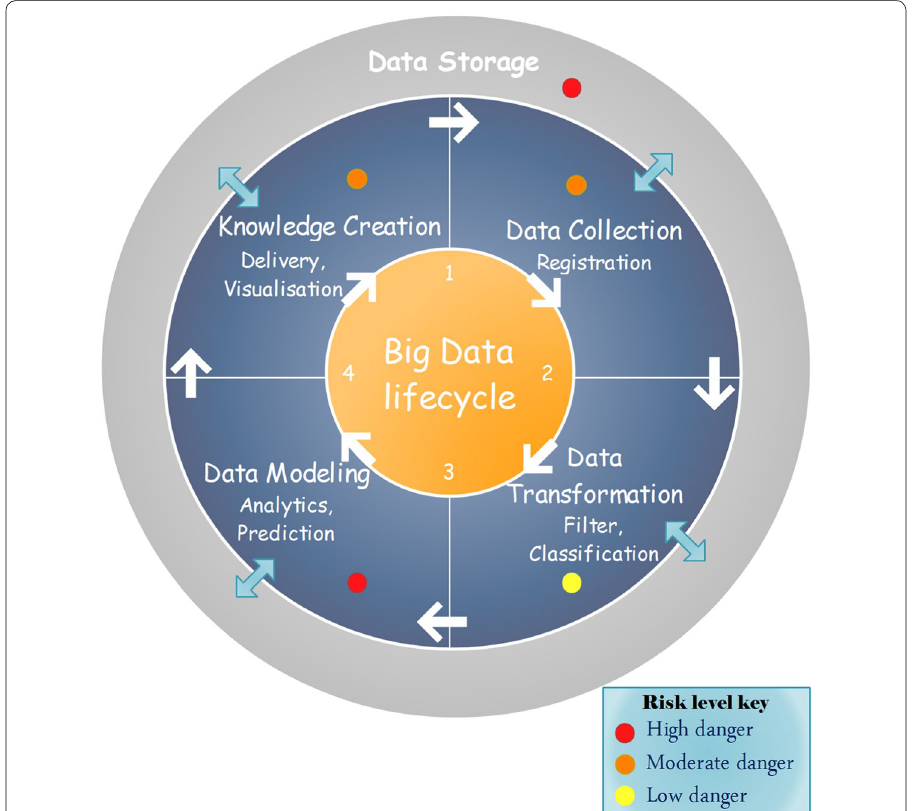
Fig. 1 Big data security life cycle in